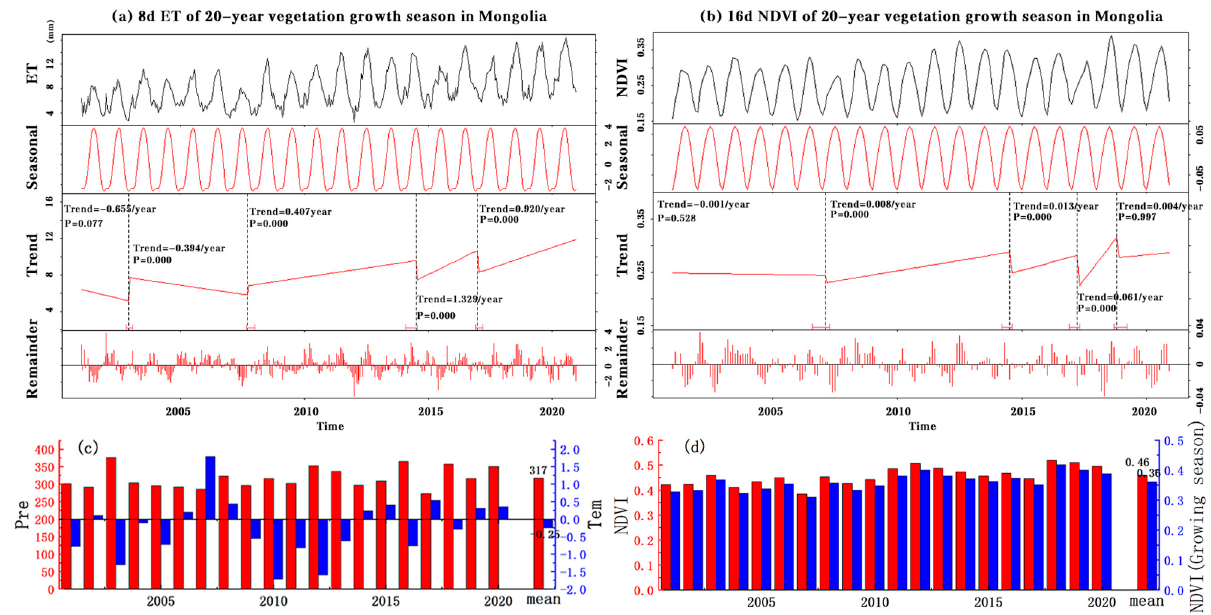
Figure 12. Abrupt breakpoints in BFAST-detected shifts in the 8-day ET for 2001–2020 at the boundary of Mongolia and for the different vegetation types of Mongolia: ( a ) ET in the growing season; ( b ) NDVI in the growing season; ( c ) 20-year average Pre and Tem; ( d ) 20-year average NDVI and NDVI in the growing season.